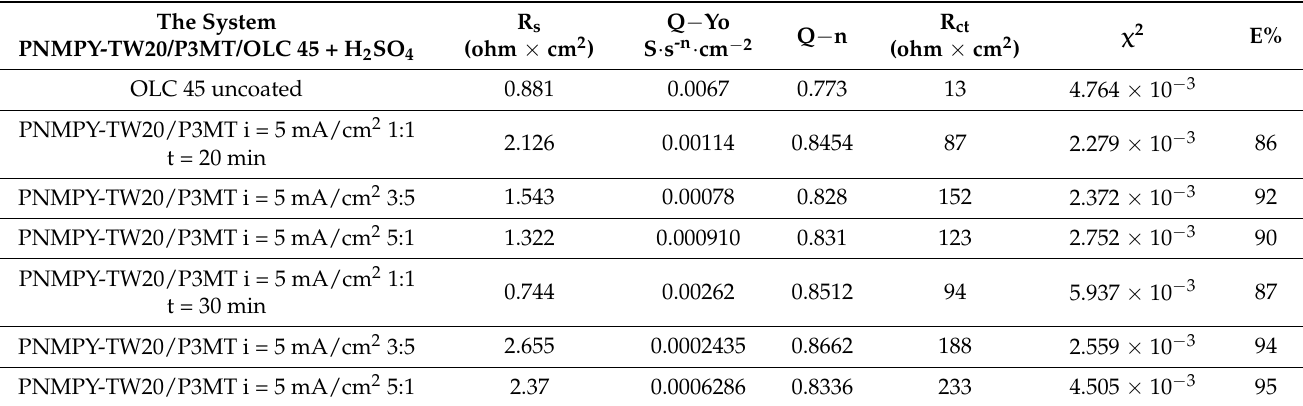
Table 7. EIS parameters of uncoated and coated by PNMPY-TW20/P3MTof OLC 45 sample in 0.5 M H 2 SO 4 medium at 25 ◦ C.